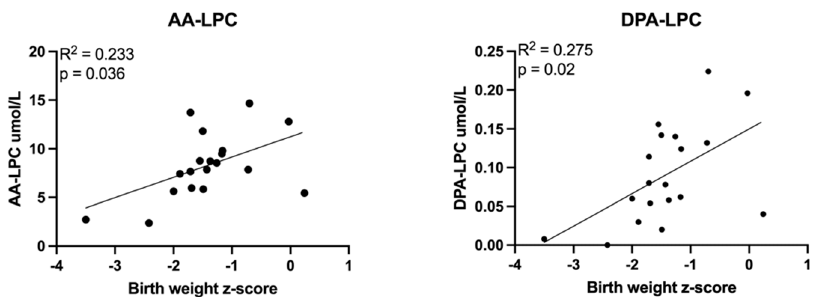
Figure 7. Correlations between umbilical vein plasma lipid concentrations and birth weight z–scores : lysophosphatidylcholines. Scatterplots demonstrate the correlation relationships between birth weight z-score and plasma lysophosphatidylcholine (LPC) molecules containing long chain polyunsaturated fatty acids. Abbreviations: AA, arachidonic acid; DPA, docosapentaenoic acid. Spearman’s rank correlation was computed to assess relationships.